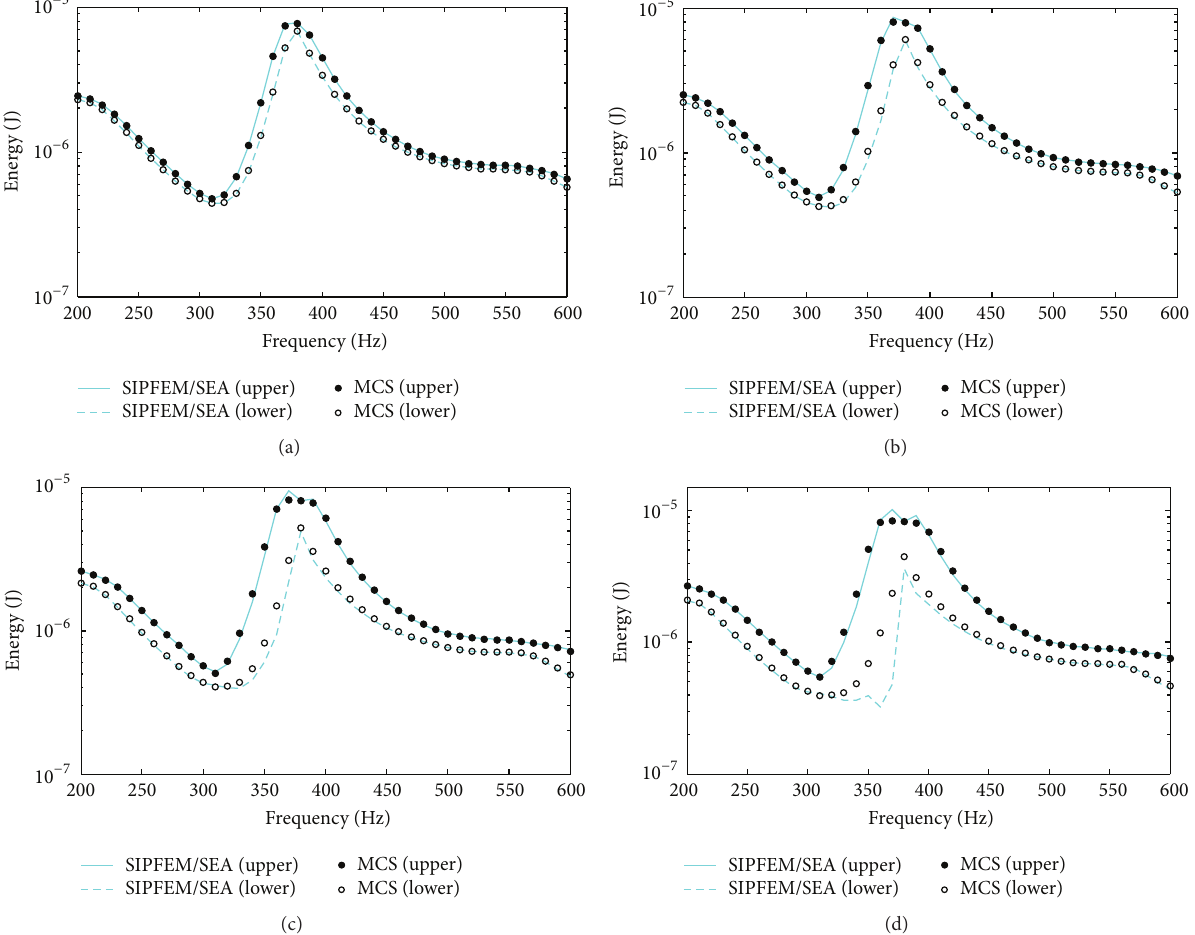
Figure 7: The bounds of the plate energy: (a) 𝛼 = 0.01 ; (b) 𝛼 = 0.02 ; (c) 𝛼 = 0.03 ; (d) 𝛼 = 0.04